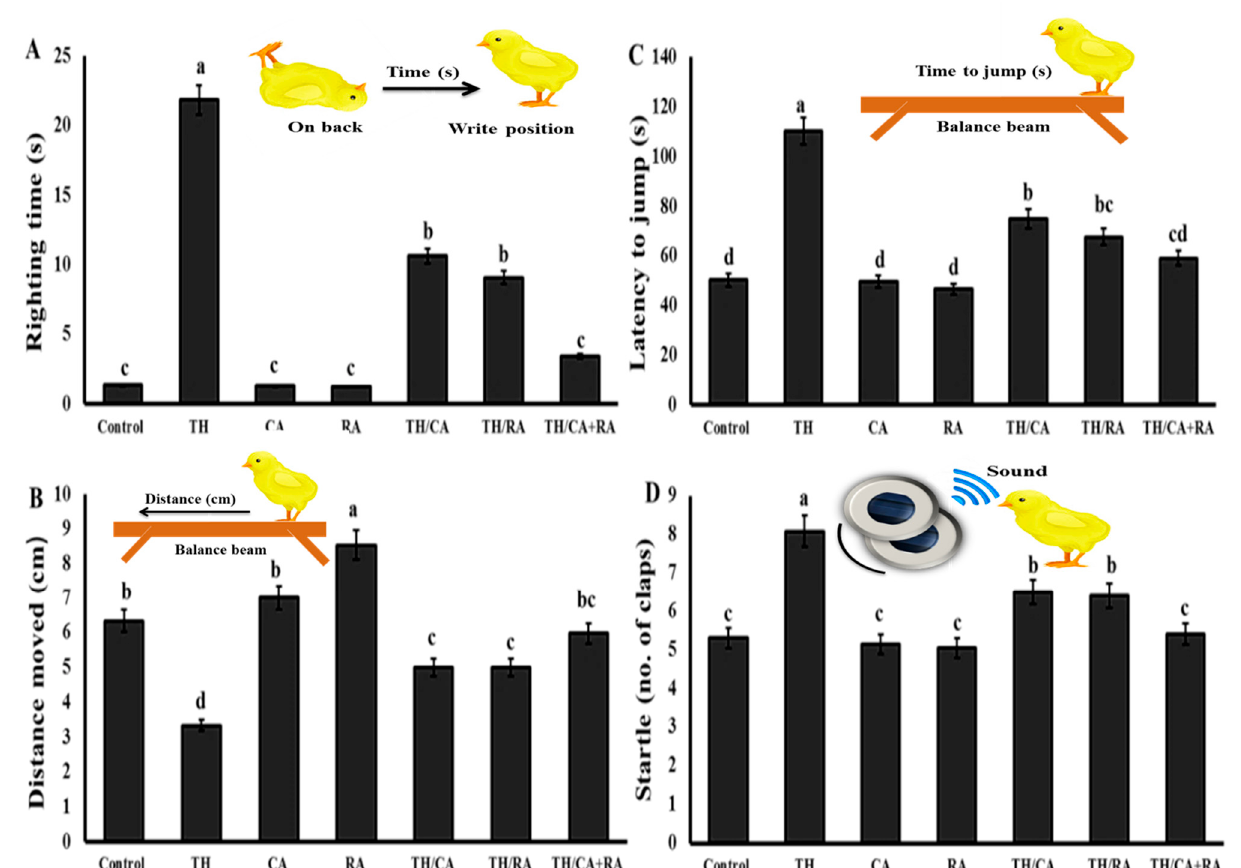
Figure 3. Effect of thiacloprid (TH), chicoric (CA), and rosmarinic acids (RA) in ovo exposure on ( A ) Righting time, ( B ) Distance moved, ( C ) Latency to jump, and ( D ) startle. Values are mean ± SEM, bars that are not sharing a common superscript letter (a–d) differ significantly at p < 0.05.